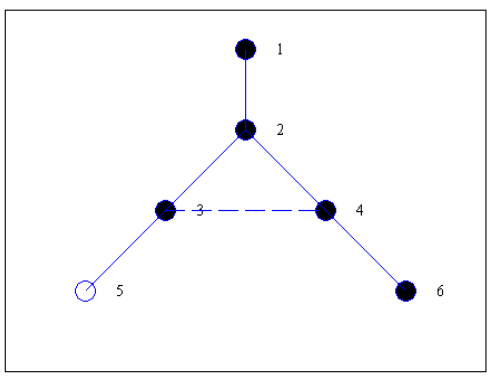
Figure 1. An example network with six nodes.